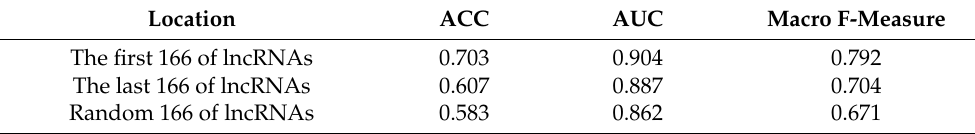
Table 5. Comparison of lncRNA subsequences at various positions.